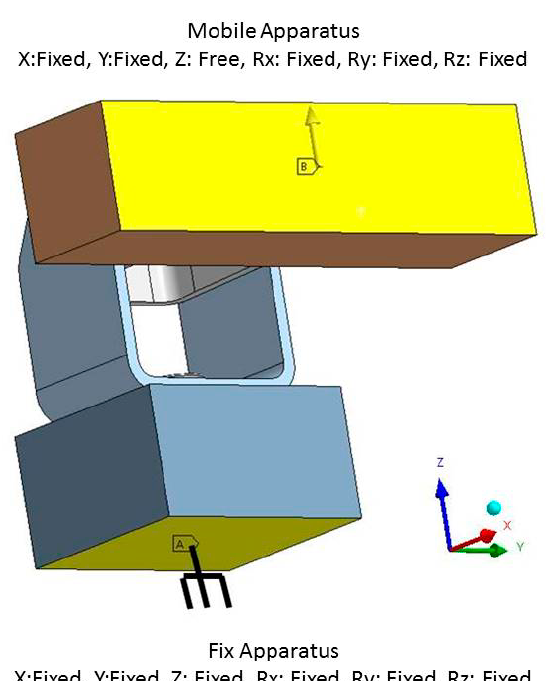
Figure 16. Boundary conditions for loading in Z direction.